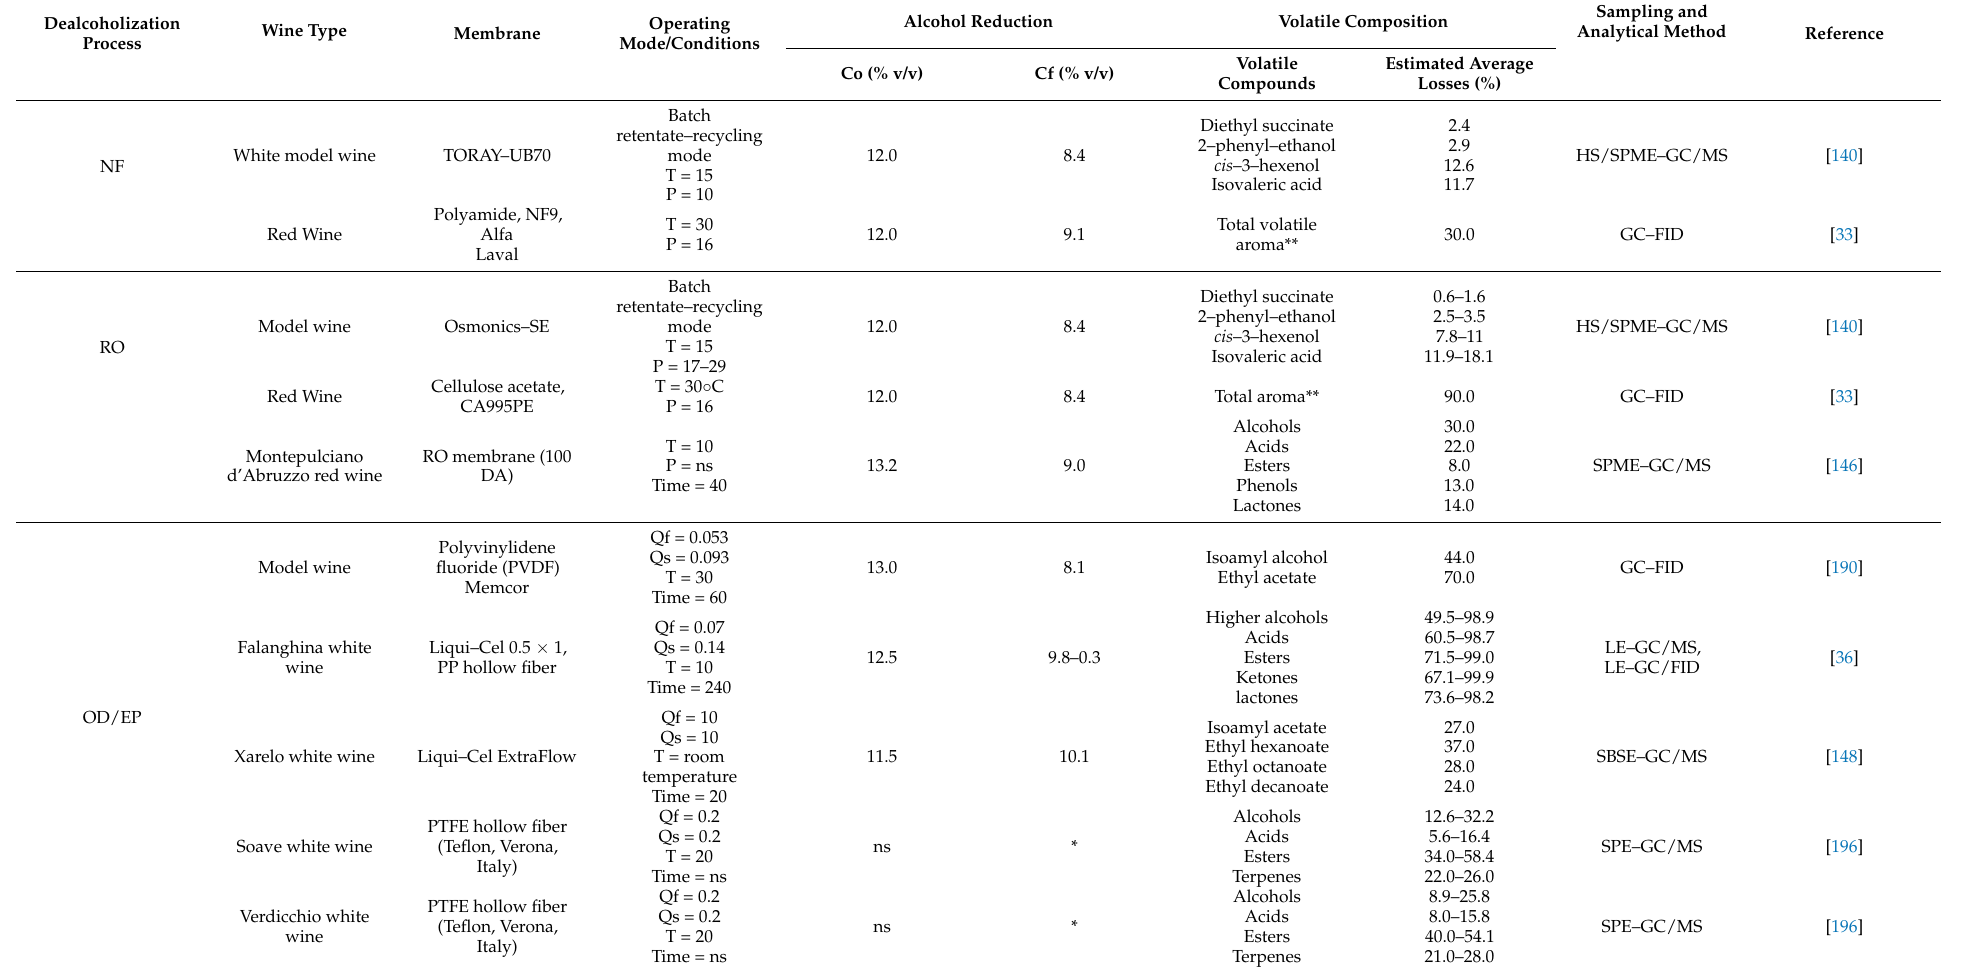
Table 3. Some reported changes in wine volatile compounds using different dealcoholization